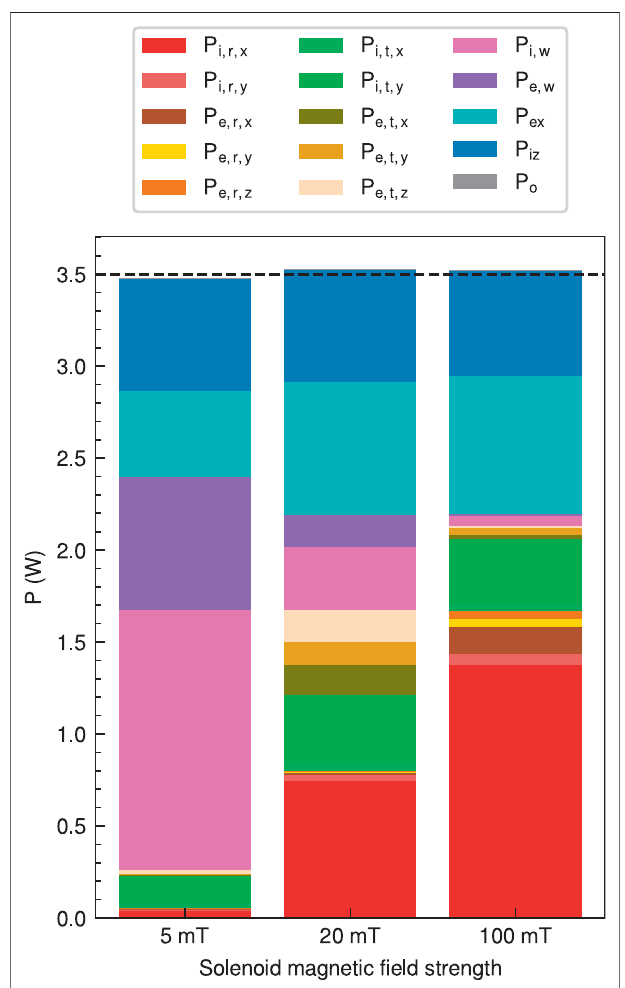
FIGURE 12 | Energy losses in the magnetic nozzle RF plasma thruster for the three magnetic fi eld strengths of 5 (a left bar), 20 (a center bar), and 100 mT(arightbar).Thede fi nitionsofenergylossesaredescribedin Table1 . P o contains other energy losses and isde fi ned by P o (cid:1) P i , r , z + P i , t , z + P el . The input power P in is set to 3.5 W for all magnetic fi eld strengths; therefore, the total energy losses are also approximately 3.5 W, shown as a dashed black line.